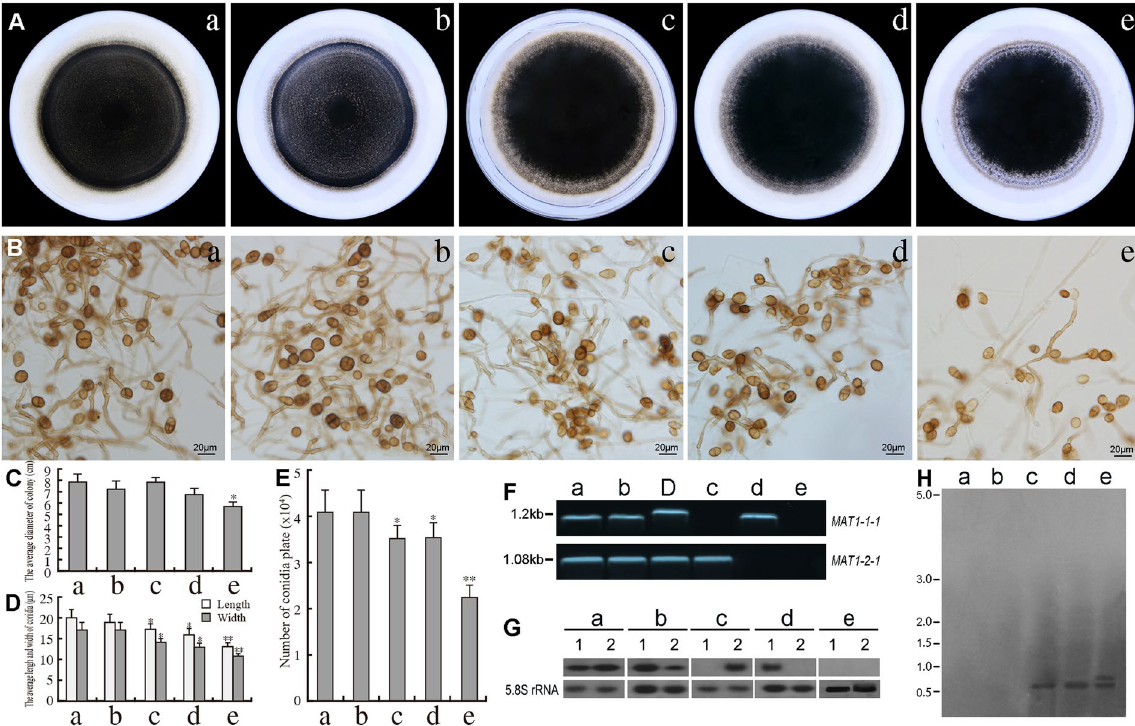
Figure 1. Effect of deletion of the U. botrytis MAT genes on colony morphology, conidial size and number. ( A , C ) Growth and diameter of the colonies of different mutants at 12 days after incubation. Colony growth rates were determined from at least 25 plates. ( B , D ) Variation in conidial size. L = Length, W = Width. The average size of conidia was determined from at least 50 conidia. Photographs were taken 12 days after incubation. ( B , E ) Variation in conidial number. The number of conidia produced per plate from cultures grown on PCA plates for 12 days under standard conditions. Error bars represent standard errors calculated using three replicates for each sample. ‘ * ’ indicates a significant difference from WT ( P < 0.05) using Student’s t - test . ‘ ** ’ indicates a significant difference from WT ( P < 0.01) using Student’s t - test . ( F ) PCR analysis of the transcription of the MAT genes in different deletion lines. D-DNA template of WT. ( G ) Northern blot analysis. Twenty micrograms of total RNA, isolated from WT, CK, and all mutant strains, were loaded per lane. The Northern blot was probed using MAT1-1-1 and MAT1-2-1 gene-specific probes. A 5.8S rRNA-specific probe was used as positive control. ( H ) For Southern blot analysis, both hygB and G418 specific probes were used to detect transgene insertion. WT and CK have no hygB and G418 specific insertion. a WT (Wild-type U. botrytis ). b CK is an empty vector transformant. c Δ matUbMAT-1 , G418 was used to detect transgene insertion. d. Δ matUbMAT-2, hygB was used to detect transgene insertion. e DmUbMAT - 1 , hygB and G418 were individually used to detect transgene insertion. Each experiment was repeated at least three independently Heterothallic C. heterostrophus MAT1-1-1 and MAT1-2-1 also influence vegetative growth and asexual sporulation in U. botrytis . To test the functions of the C. heterostrophus MAT1-1-1 and MAT1-2-1 in the stable U. botrytis deletion mutants Δ matUbMAT-1 , Δ matUbMAT-2 , and DmUbMAT-1 , we created transformants Δ matUbMAT-1 { ChMAT }, Δ matUbMAT-2 { ChMAT }, DmUbMAT-1 { ChMAT } -1 , DmUbMAT-1 { ChMAT } -2 , and DmUbMAT-1 { ChMAT } - 3 using previously described methods. Each of the U. botrytis MAT deletion mutants was transformed with the corresponding gene from C. heterostrophus , i.e., Δ matUbMAT-1 { ChMAT } contains the MAT1-1-1 gene of C . heterostrophus . Each of these transgenes conferred to the MAT deletion mutants of U. botrytis the same phenotypes of colony growth, conidial number and size, and compartmentalization (data not shown). Thus, we only analyzed the five typical transformants Δ matUbMAT- 1 { ChMAT } -1 , Δ matUbMAT- 2{ ChMAT } -1 , DmUbMAT-1 { ChMAT } -1-1 , DmUbMAT -1{ ChMAT } -2-1 , and DmUbMAT-1 { ChMAT } -3-1 in subsequent experiments (Table S1). The PCR, Southern blot, and qRT-PCR anal- yses of these five typical transformants are shown in Fig. 2F,G,H. The colony diameters of these five transformants (Fig. 2A,C: c,d,e,f,g) were very similar to WT and CK (Fig. 2A,C: a,b). The colony borders of Δ matUbMAT-1 { ChMAT } -1 and Δ matUbMAT-2 { ChMAT } -1 (Fig. 2A: c,d) are incompact in contrast to WT and CK (Fig. 2A: a,b) and three other typical transformants in the DmUbMAT-1 background (Fig. 2A: e,f,g). Notably, no significant differences in the colony borders between Δ matUbMAT- 1 { ChMAT } -1 and Δ matUbMAT - 2 { ChMAT }- 1 (Fig. 2A: c,d) and the two single mutants Δ matUbMAT-1 and Δ matUbMAT-2 (Fig. 1A: c,d) were found under standard conditions. As shown in Fig. 2A: e,f,g, the cultures of these three DmUbMAT-1 transformants became loose and ringed in a slight gray color while the single gene